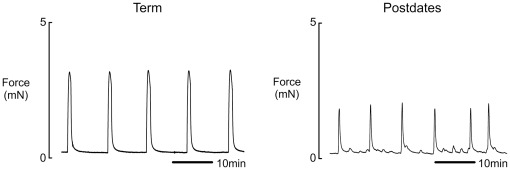
Contractile activity in term and postdates labouring myometrium.Representative isometric recordings of spontaneously contracting myometrial strips obtained from women undergoing Caesarean section in labour at term (39–41 weeks) and postdates (≥41weeks+3). Strips were placed under a resting tension of 2 mN and superfused continually with physiological saline solution (pH 7.4) at 37°C.